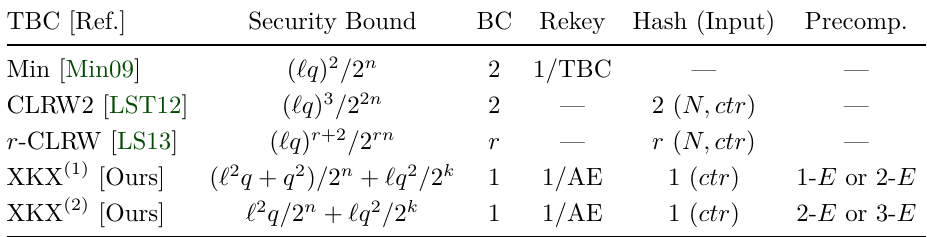
Table 1: Comparison of security and efficiency of BBB-secure TBCs. This table considers ΘCB3-based and OTR -based schemes whose underlying TBCs are given in the left most column. In these bounds, it is assumed that the influences of the decryption queries and associated data are sufficiently small. “BC” shows the number of blockcipher calls per one data block. In “Rekey,” “1/TBC” means that a key scheduling is performed for each TBC call, and “1/AE” meas that a key scheduling is performed for each AE query. “Hash” shows the number of keyed hash function evaluations in one TBC call, and in the parentheses, the inputs are given. In “Precomp.,” i - E means that a blockcipher is called i times in a precomputation